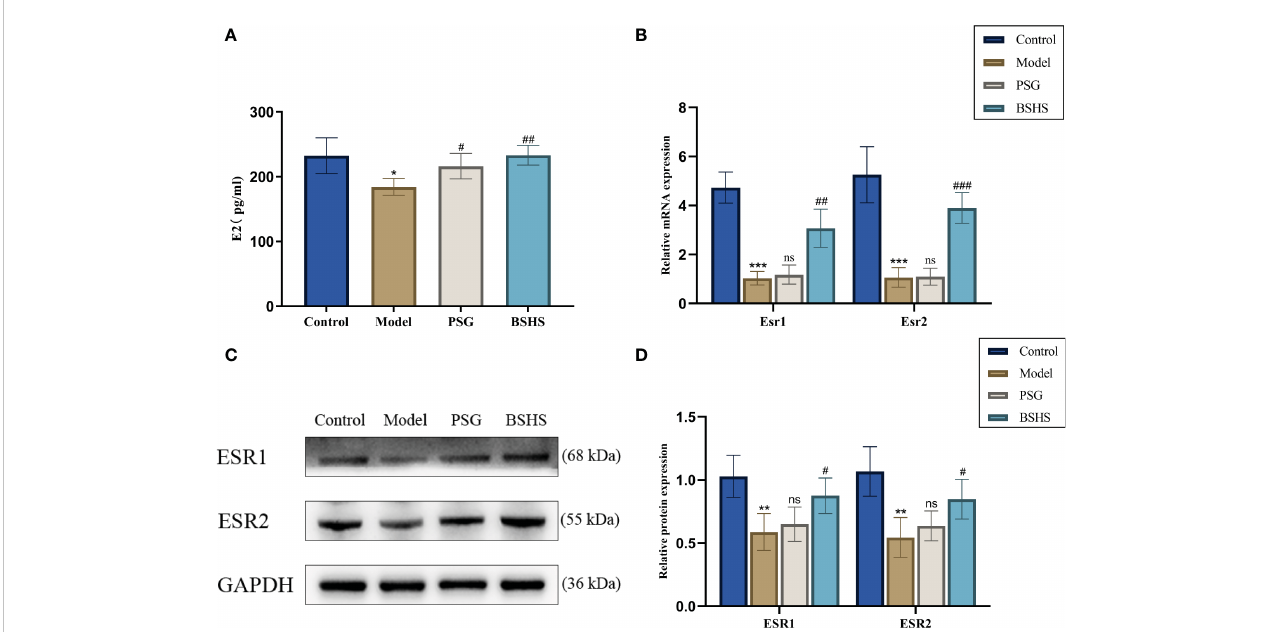
FIGURE 5 The effect of BSHS on the imbalance of estrogen levels induced by EG+AC in the rat. (A) ELISA evaluated the expression of estrogen levels. (B) The expression of estrogen receptor-related genes was evaluated by qRT-PCR. (C) The expression of estrogen receptor-related proteins was examined by Western blotting. (D) A semi-quantitative analysis of ESR1 and ESR2 is shown. Data are presented as the mean ± SD and density normalized to GAPDH. * p <0.05 vs . the normal control group, ** p < 0.01 vs . the normal control group, *** p < 0.001 vs . the normal control group, # p < 0.05 vs . the model group, ## p < 0.01 vs . the model group, ### p< 0.001 vs . the model group, ns for p > 0.05 vs . the model